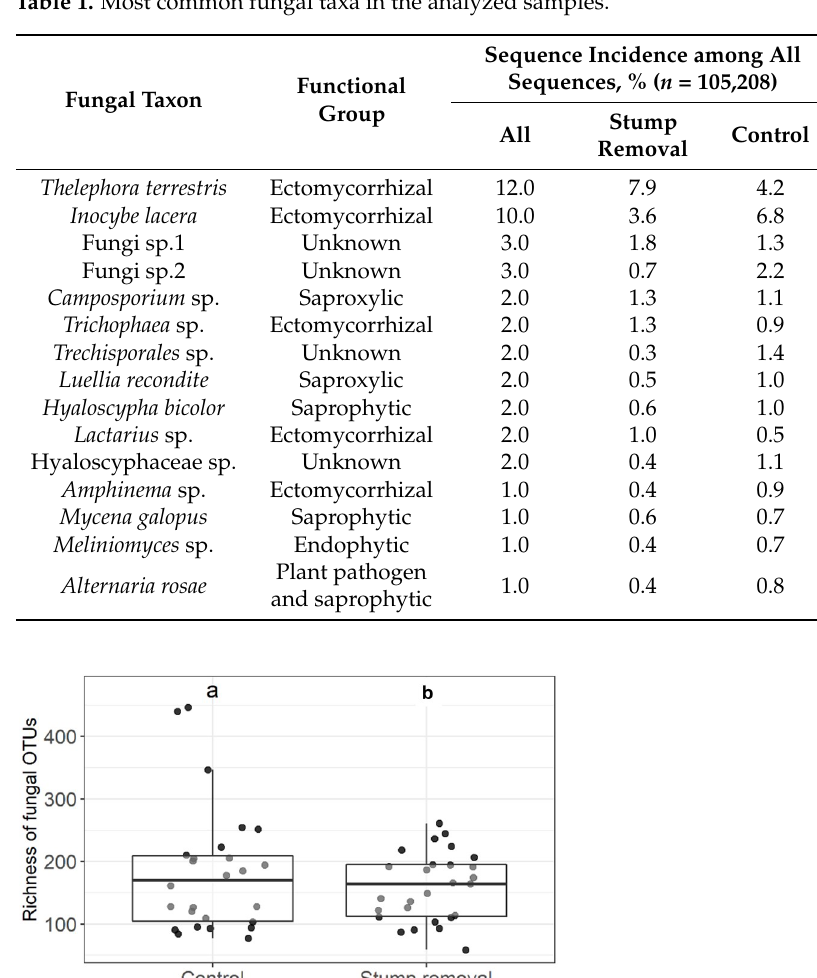
Table 1. Most common fungal taxa in the analyzed samples.